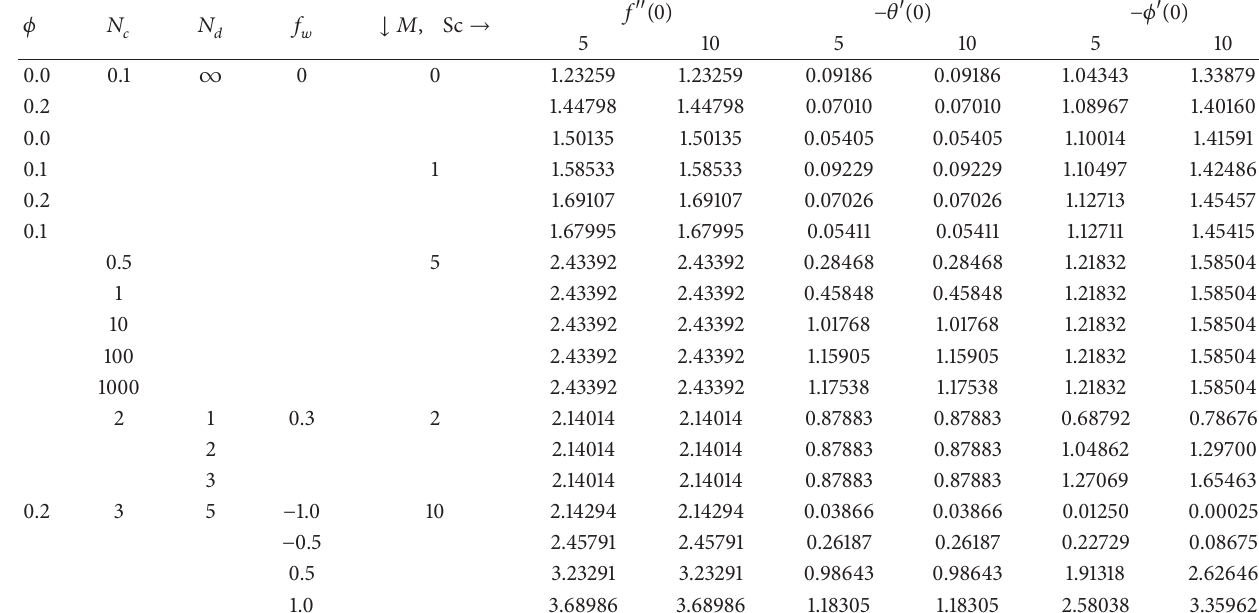
Table 3: Values related to the reduced skin friction coefficient and reduced Nusselt and Sherwood numbers for different values of the governing parameters (for Cu-water).